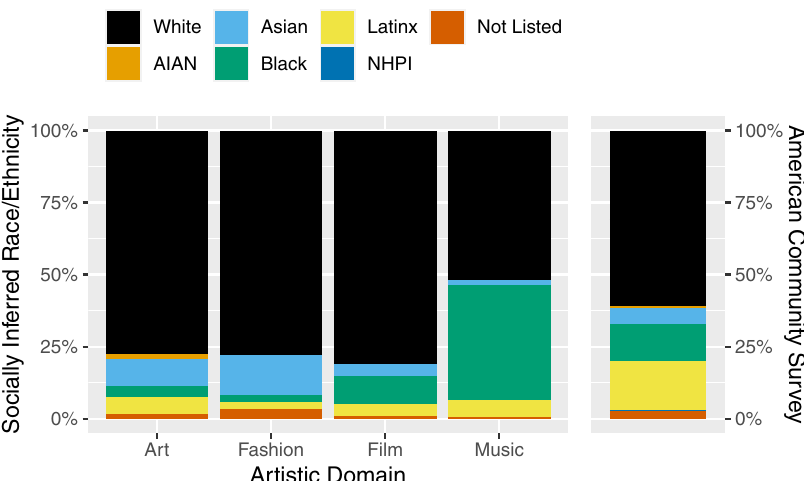
Fig. 2 Socially inferred race/ethnicity across four creative domains and as derived from American Community Survey (ACS) data (U.S. Census Bureau, 2019). As compared to the ACS, marginalized racial/ethnic groups are underrepresented in most domains. Note: AIAN American Indian/Alaska Native, NHPI Native Hawaiian/Paci fi c Islander, Not Listed an identity not captured by the other choices. See Table 1 for numerical data.